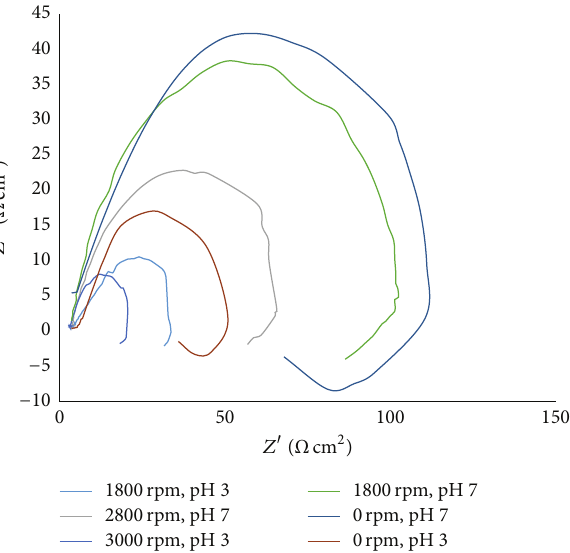
Figure 3: Nyquist diagrams of AISI 4330 steel electrode at the various pH solutions and rotating speeds in solutions containing 3 wt.% NaCl with a constant concentration of 10wt.% silica particles (105 𝜇